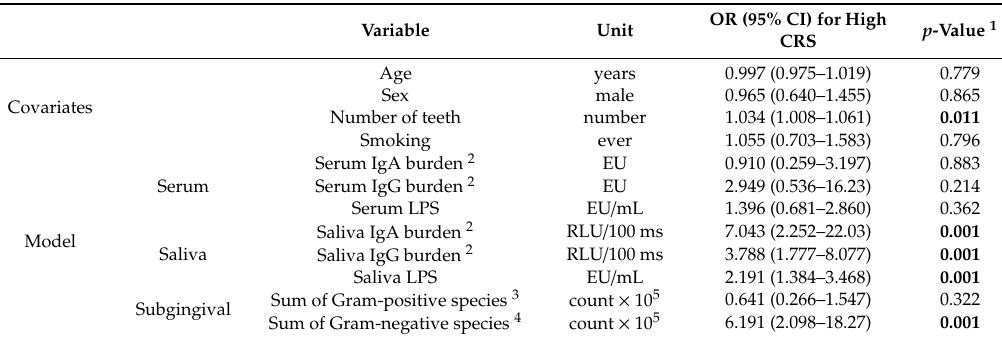
Table 5. Association of high CRS with antibody and subgingival bacterial